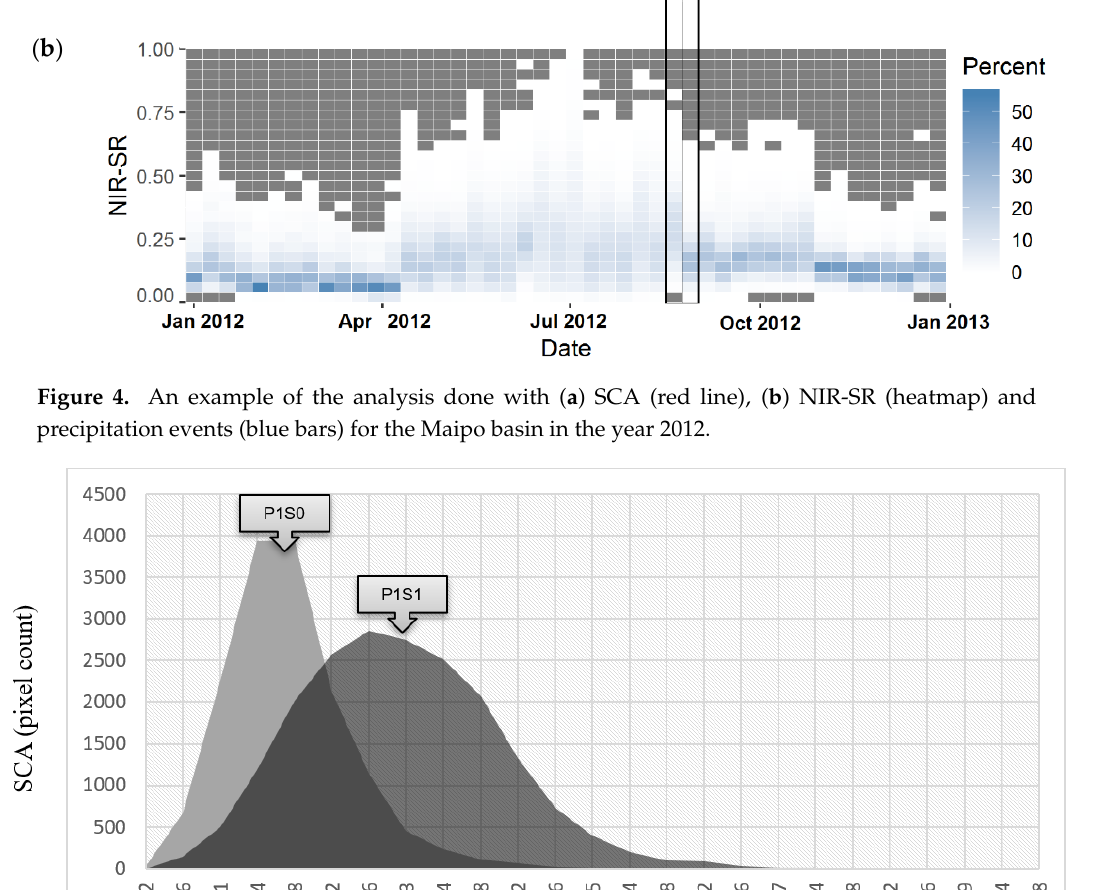
Figure 4. An example of the analysis done with ( a ) SCA (red line), ( b ) NIR-SR (heatmap) and precipitation events (blue bars) for the Maipo basin in the year 2012.